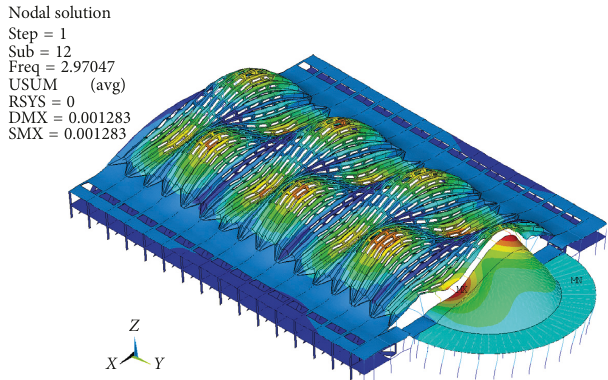
Figure 15: Mode 12 of Hall B in its damaged configuration (apse